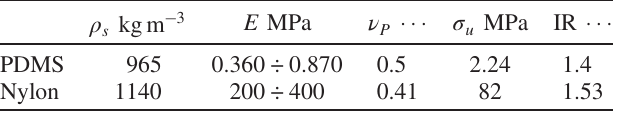
TABLE I. Physical properties of the employed material. The table reports the volumetric density ρ s , the Young ’ s modulus E , the Poisson ratio ν P , the ultimate tensile stress σ u , and the refractive index IR. Triple dots indicate dimensionless quantity.